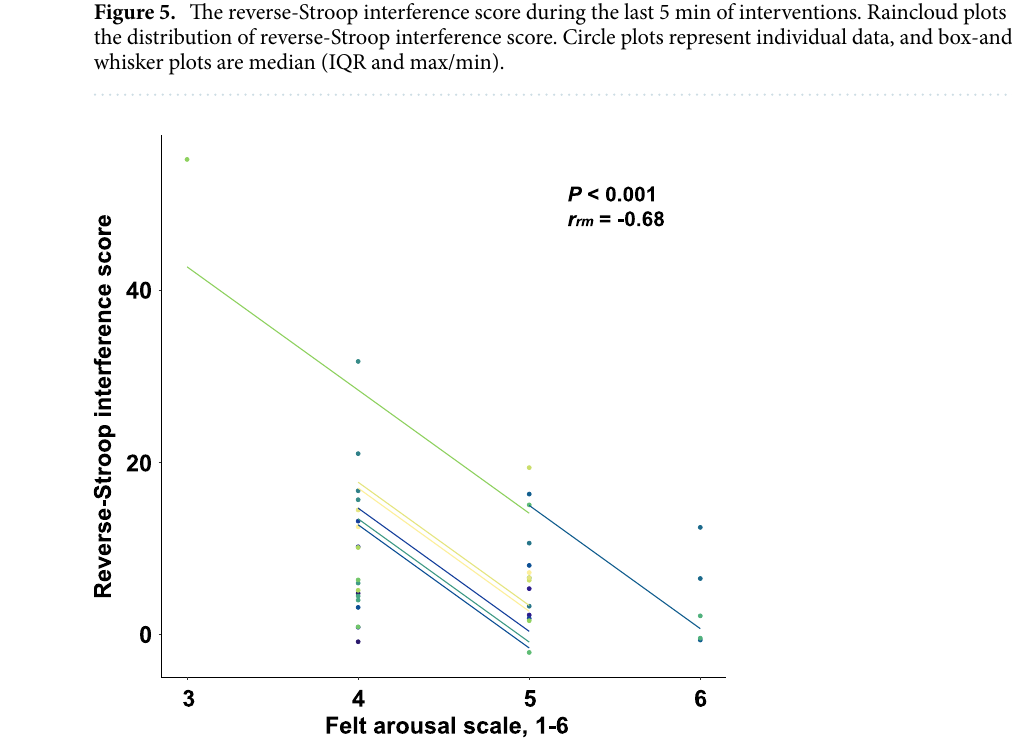
Figure 6. Repeated measures correlations (rmcorr) between the reverse-Stroop interference score and arousal in response to EX and pCL EX conditions. Circle plots represent individual data, and lines show the rmcorr coefficient ( r rm ) fit for the participants. Same colour represent data from the same